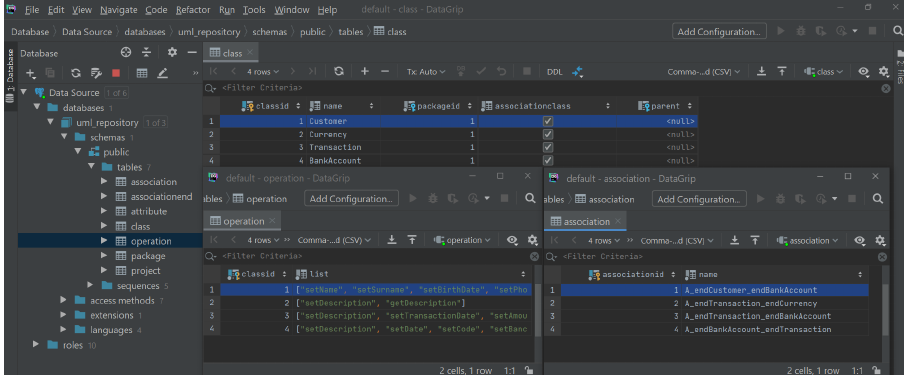
Figure A1. The tables of the metadata repository about class diagrams and a subset of their tuples coming from the case